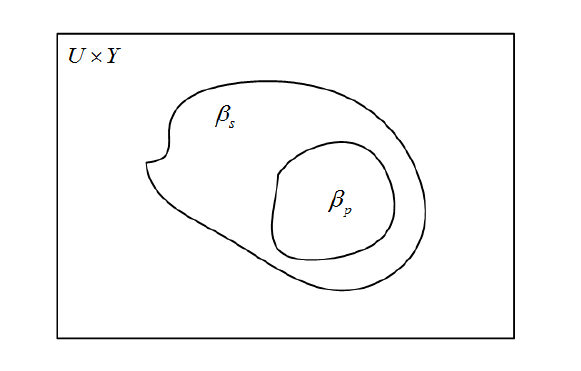
Figure 2. Process behavior